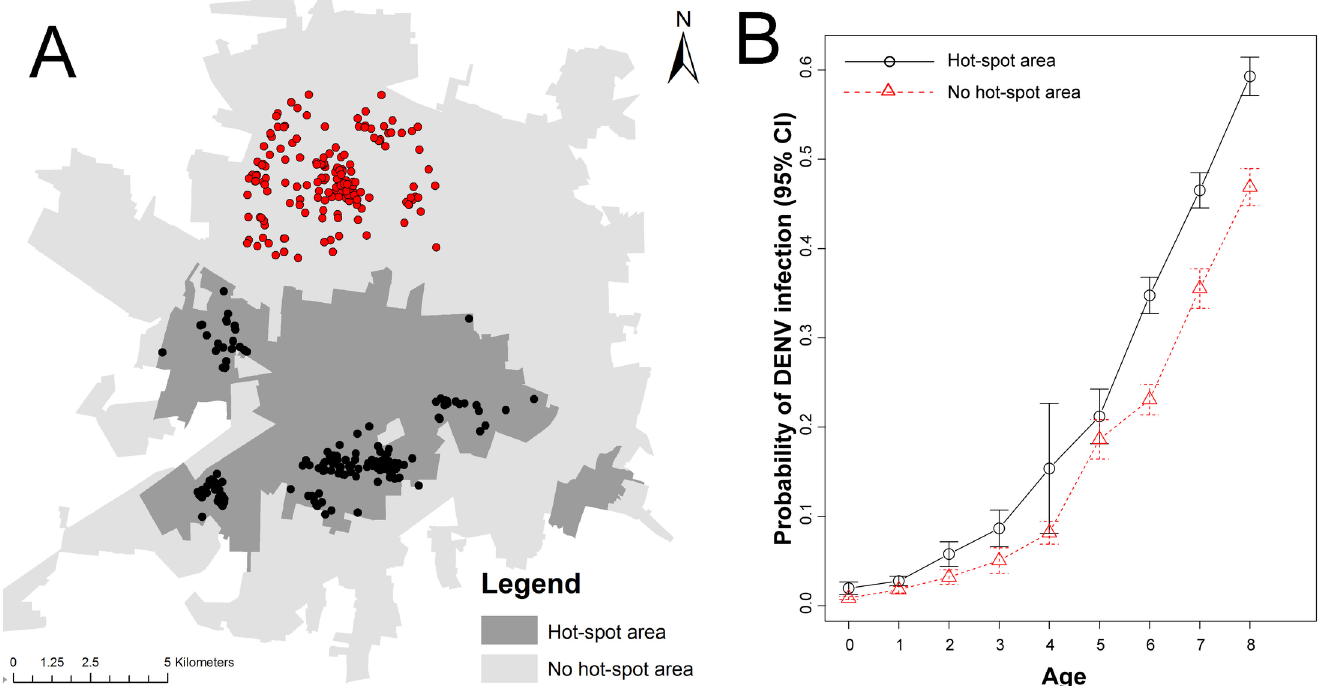
Fig 2. Validation of DENV spatial clustering. (A) location of the residence of 505 children aged 8 or younger and who provided a blood sample in 2015, stratified by those residing inside (black) and outside (red) the 2008–2015 DENV hot-spot area. (B) Average DENV infection probability, estimated from a mixed-effects logistic regression model, for the children living inside (black solid line) or outside (red dotted line) the 2008–2015 DENV hot-spot area. Error bars indicate the standard error of the mean. Details of the model are shown in Table 1. Source of the census tract boundaries was INEGI, 2010.